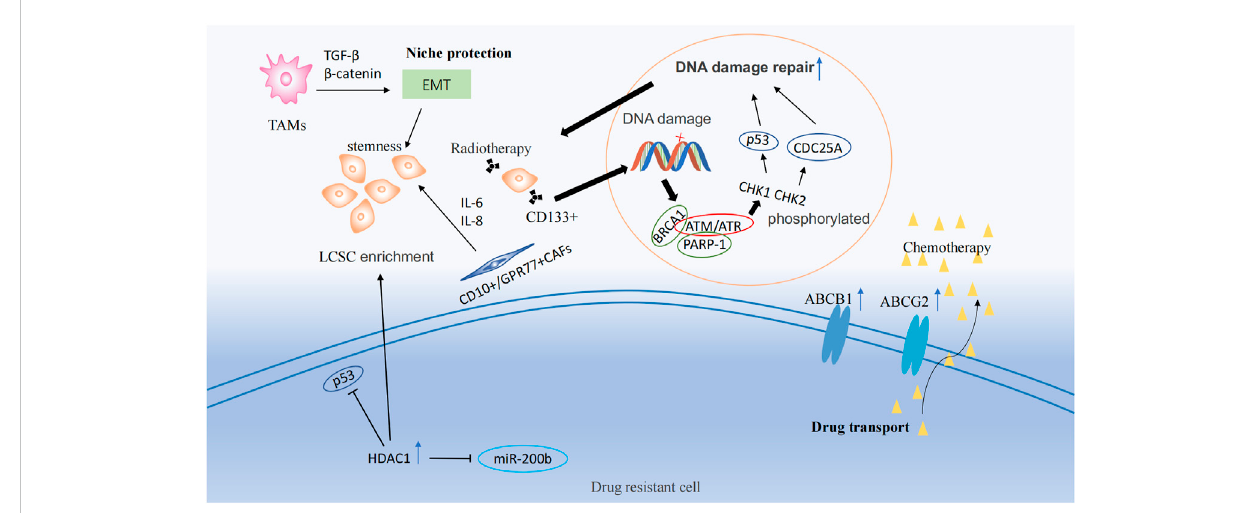
FIGURE 2 Drug resistance mechanisms and epigenetic regulation involving tumor stem cells. Drug resistance mechanisms include drug transport, DNA damage repair, and ecological niche protection processes. LSCS: lung cancer stem cell; TAMs: Tumor-associated macrophages; EMT: Epithelial- Mesenchymal Transition; CAFs: cancer associated fi